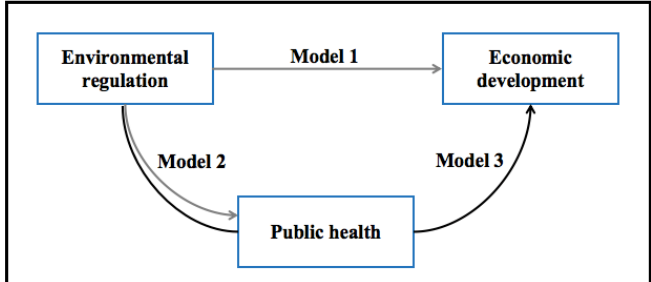
Figure 4. Research Figure 4. Research model.